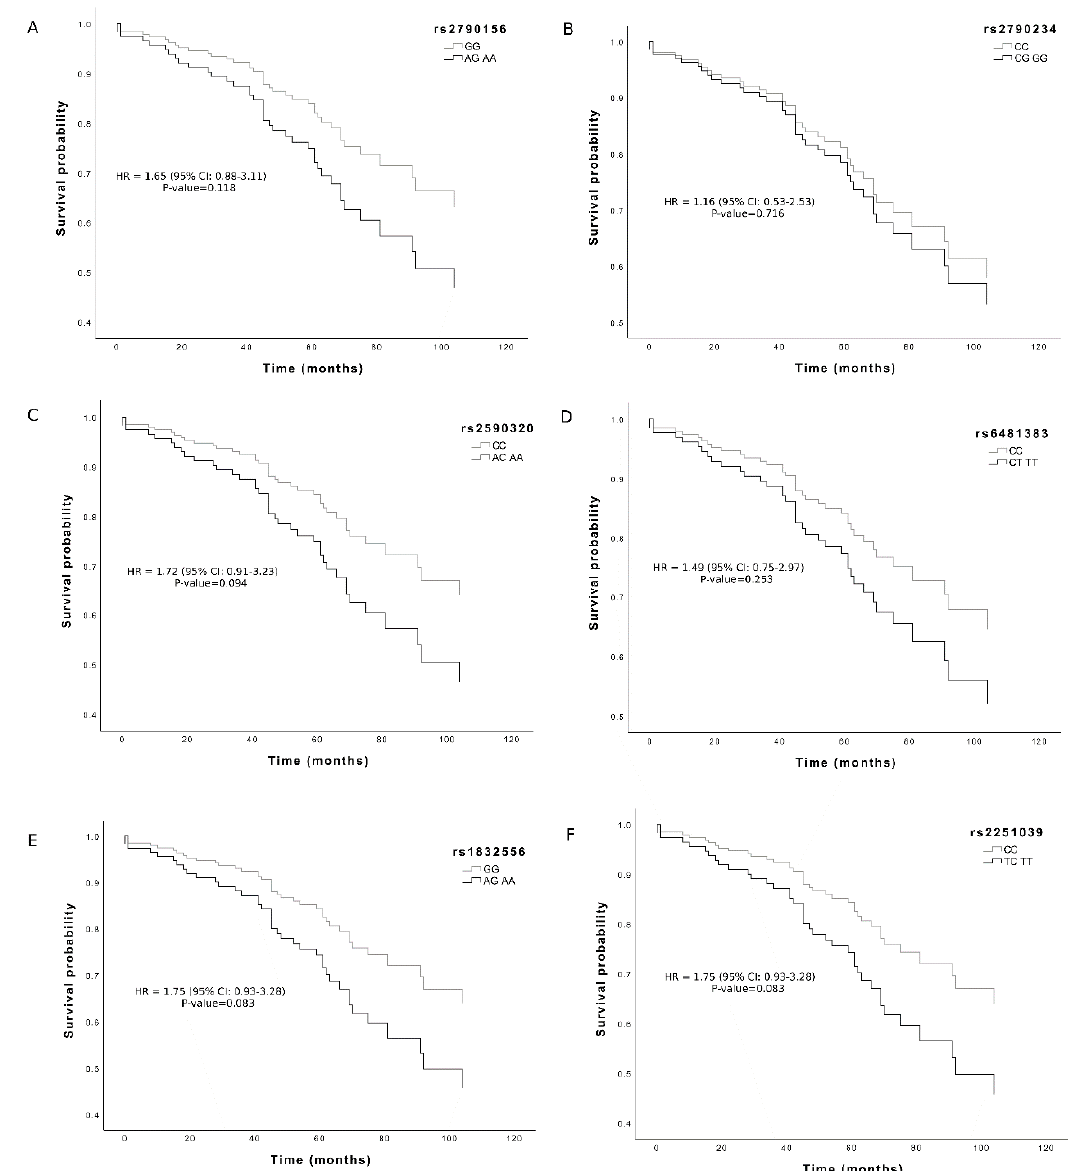
Figure 2. Survival functions of female carriers of minor allele (black) vs non-carriers (grey) of IPMK variants. ( A ) rs2790156; ( B ) rs2790234; ( C ) rs2590320; ( D ) rs6481383; ( E ) rs1832556; ( F ) rs2251039.